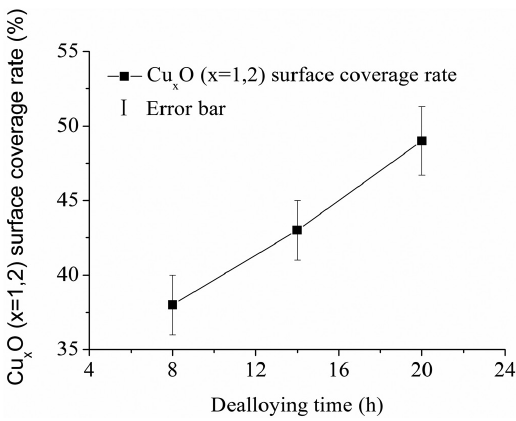
Figure 5. Cu O (x = 1,2) surface coverage rate with different x dealloying time in 0.5 M HCl solution open to air at room temperature.